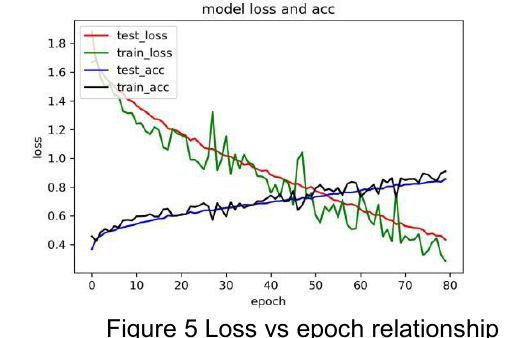
Figure 5 Loss vs epoch relationship Analysis of point cloud classification results: The